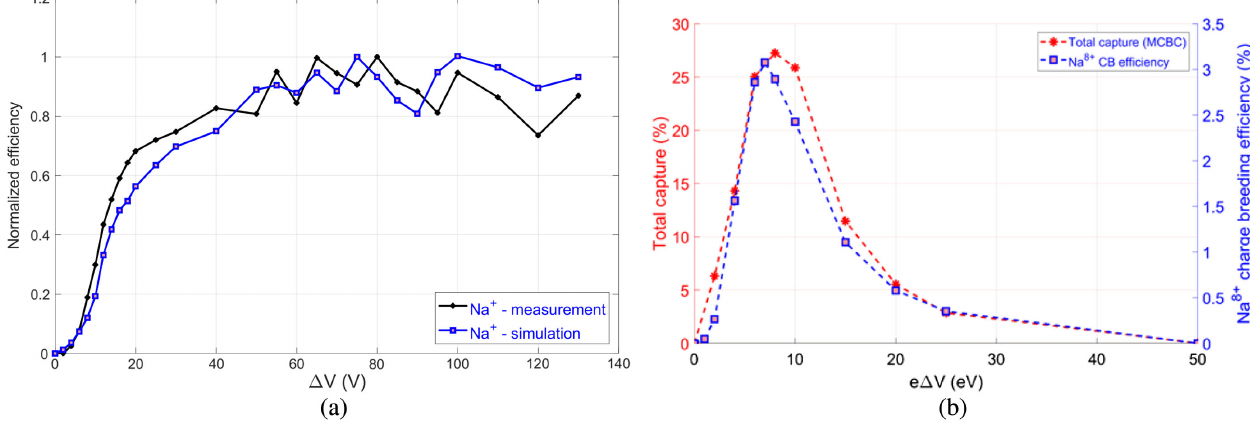
FIG. 6. (a) Comparison of simulated and experimental Na 1 þ Δ V curves. (b) Comparison between simulated 1 þ ion capture efficiency and experimental Na 8 þ Δ V curve.